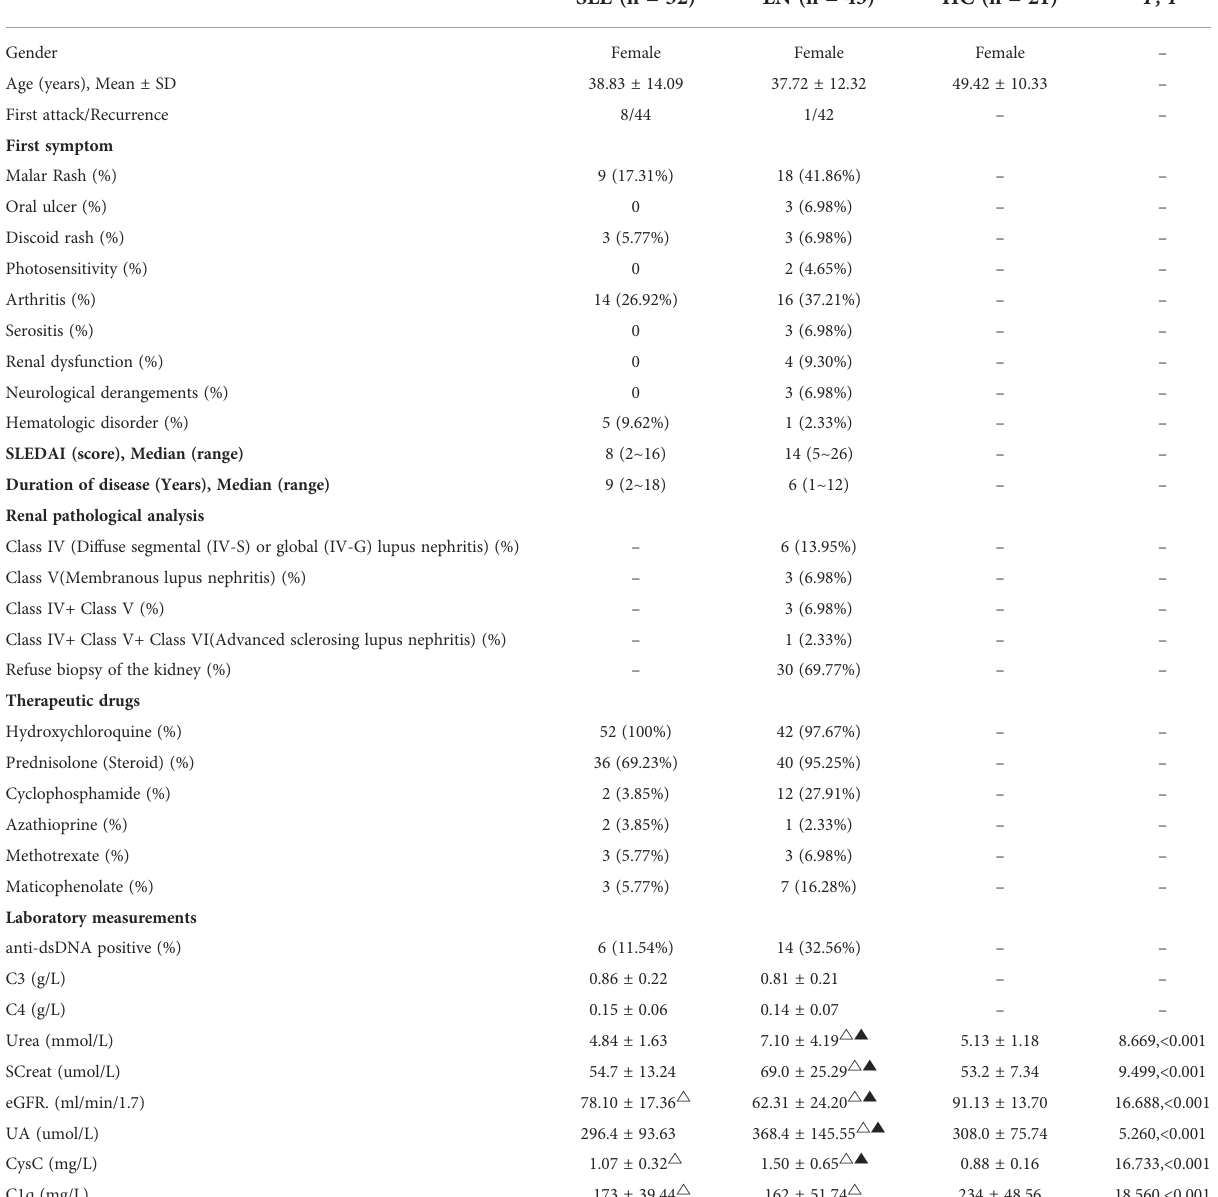
TABLE 1 Clinical data of subjects (n =